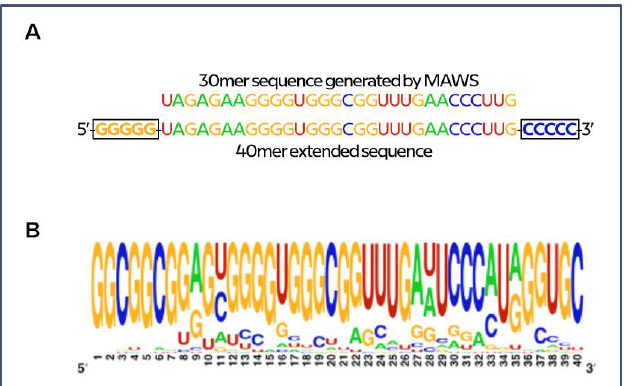
Figure 2. ( A ) Originated 30mer MAWS sequence extended to 40mer before elitist genetic algorithm mutation process (MPDR). ( B ) Weblogo image that shows residue frequencies of generated (40mer) sequences from 30mer starting sequence (https://weblogo.berkeley.edu/logo.cgi, February 2021).